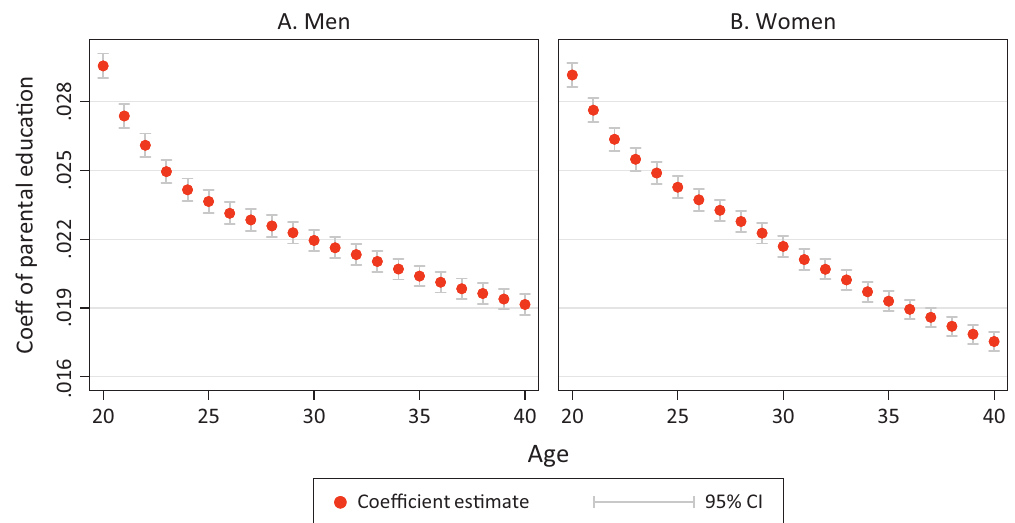
Figure 3. Completed upper secondary education: coefficient of parental education, by age and gender. Note: Scatter points are the coefficient estimates from 42 regressions run separately by age and gender of completion of upper secondary on parental